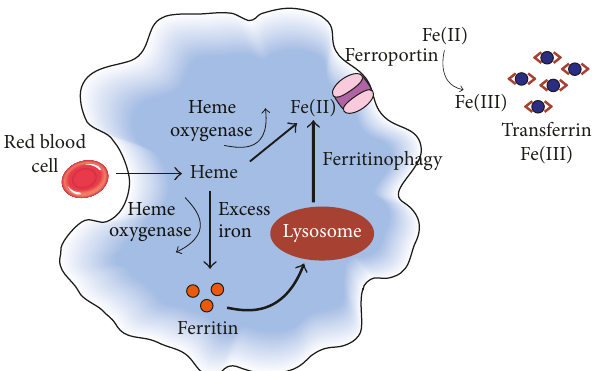
Figure 1: Normal iron homeostasis in the reticuloendothelial macrophage. Macrophages phagocytose aged or damaged red blood cells, using heme oxygenase 1 to release iron from heme, a recycling process that accounts for approximately 90% of the body’s daily iron needs. Iron is rapidly released to circulating transferrin or, when present in excess, stored in ferritin. When required, ferritin is degraded in the lysosomes via a process called ferritinophagy and the iron is released. Iron(II) is exported from the macrophage via ferroportin in the cell membrane in a process coupled to reoxidation from iron(II) to iron(III) by membrane-bound ceruloplasmin. Iron(III) is then loaded onto transferrin for transport in the plasma.